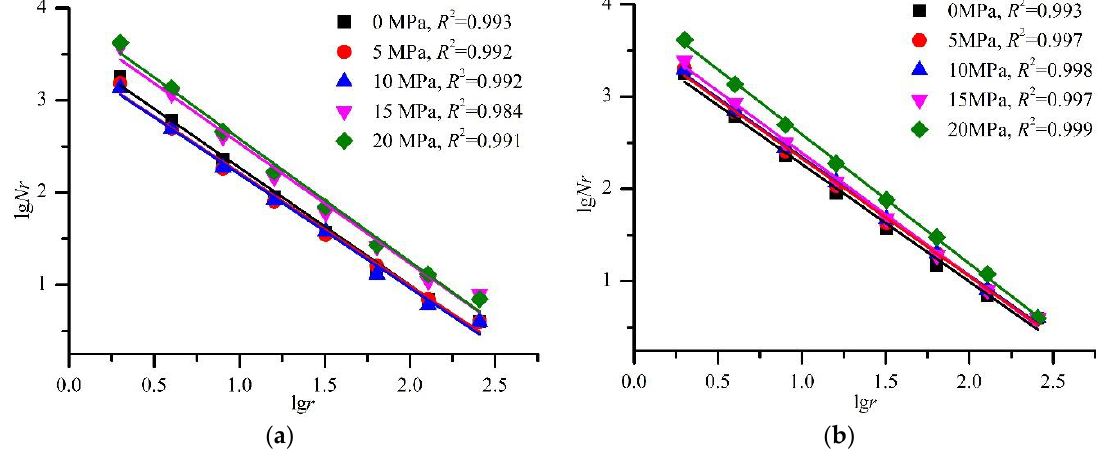
Figure 16. The fractal dimension calculation of the sandstone crack network: ( a ) Group I; ( b ) Group II.